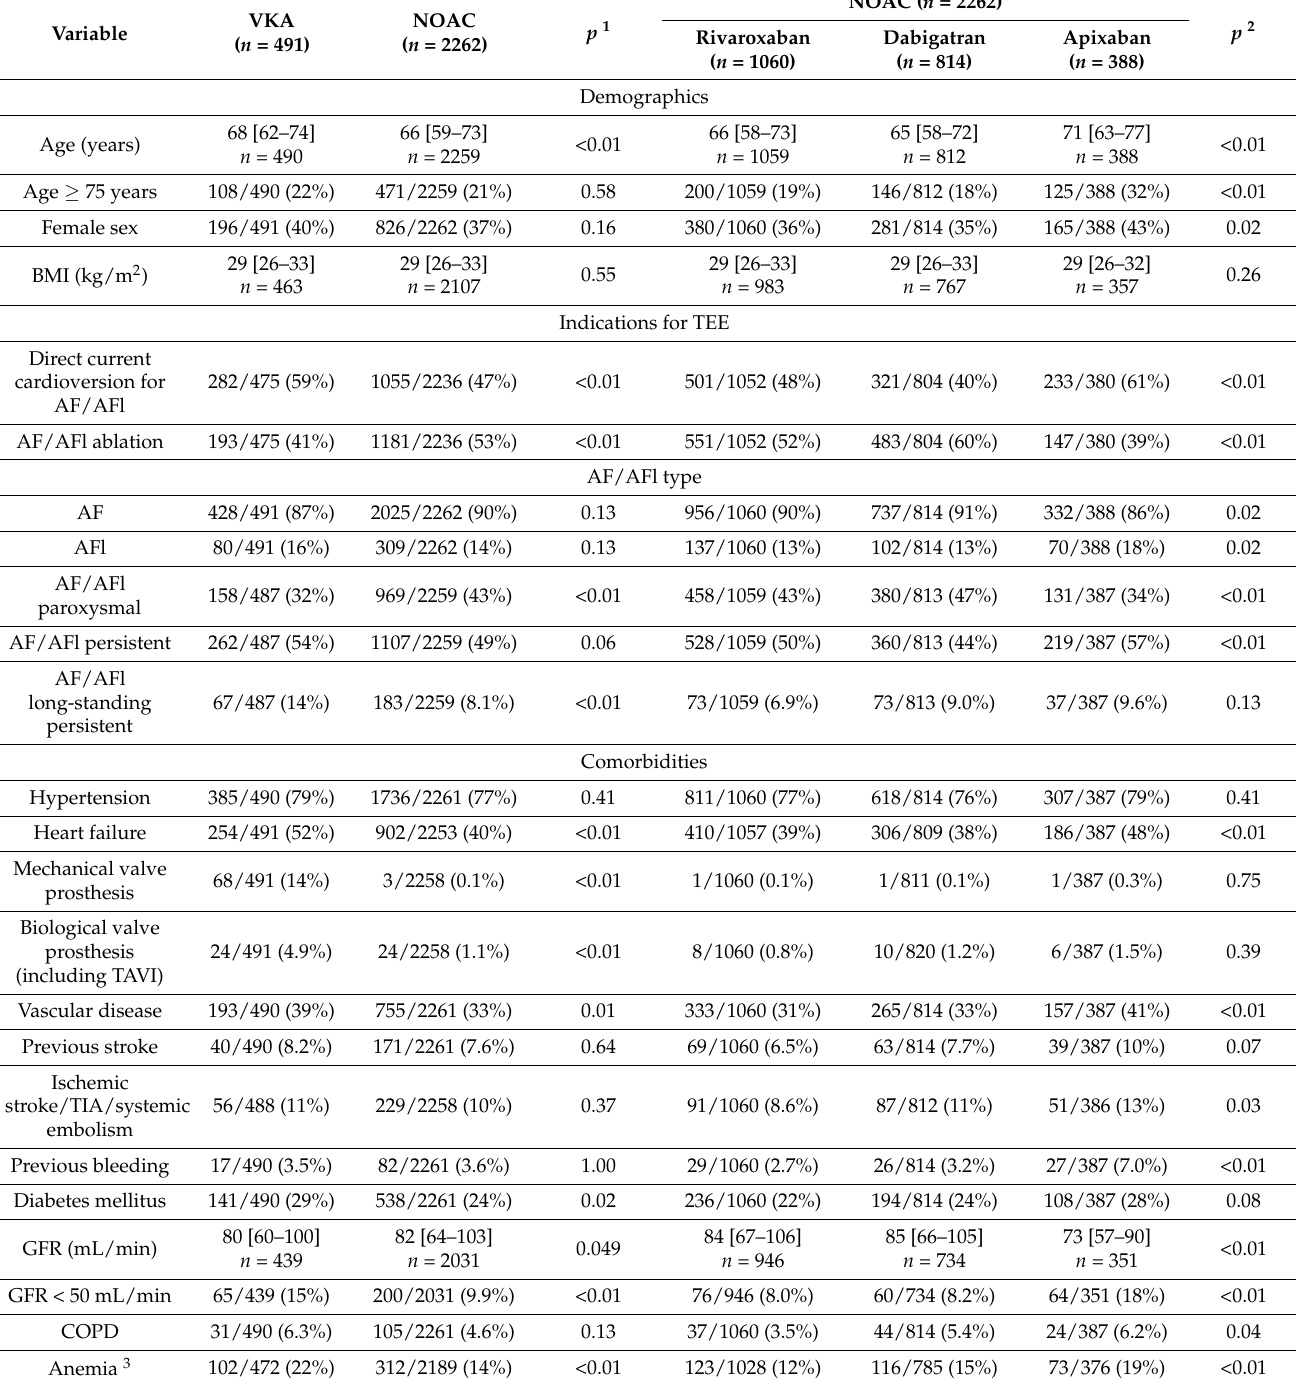
Table 1. Baseline characteristics of patients on chronic oral anticoagulation in relation to type of